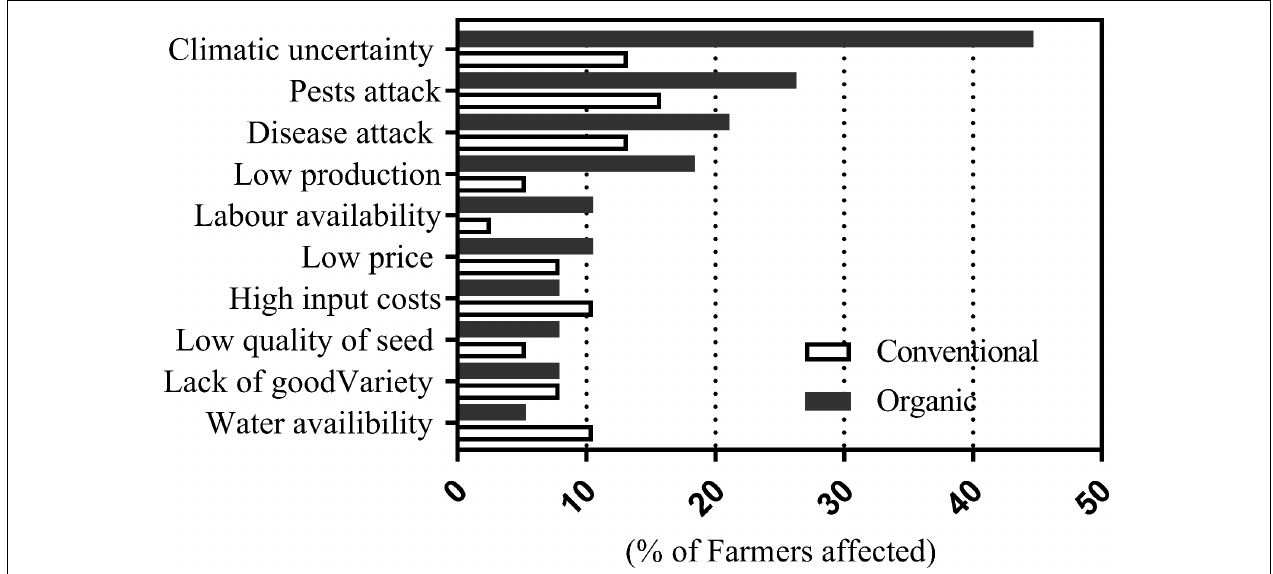
FIGURE 2 | Organic and conventional farmers’ views on major limiting factors of cotton production in Nimar